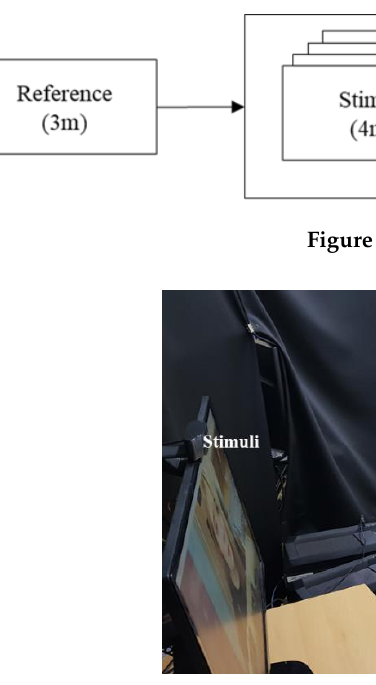
Figure 3. Experimental settings for participants with no co-viewer. Participants with co-viewer sit next to each other and shared the same display.